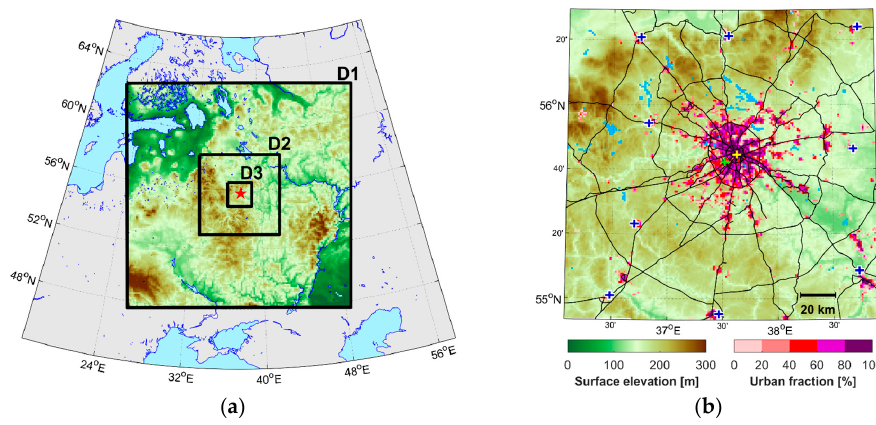
Figure 1. The configuration of the nested domains, used for simulations with the COSMO-CLM model, with surface elevation shown by the color scale, and water surfaces shown by the light-blue color ( a ). A detailed map of the finest D3 domain, used for the urban climate simulations with the COSMO-CLM model coupled to TERRA_URB, with urban fraction (UF) shown by an additional color scale ( b ). The location of the weather stations used in the study (see Section 2.6) is also shown ( b ). The yellow cross indicates Balchug station (considered as the city center), the green cross indicates MSU (Moscow State University) station, and blue crosses indicate the nine rural reference stations around Moscow. The black lines in ( b ) represent the primary road network. Modeling results for D1 were used as the initial and boundary conditions for intermediate domain D2 with a size of 600 km × 600 km (200 × 200 grid cells) and a 3-km grid spacing covering the Moscow region and the neighboring regions of Russia. Then, the same procedure was repeated for domain D3 with a size of 180 km × 180 km with a 1-km grid spacing. The final 1-km step was selected to resolve urban–atmosphere interactions and the consequential urban-caused mesoscale features.